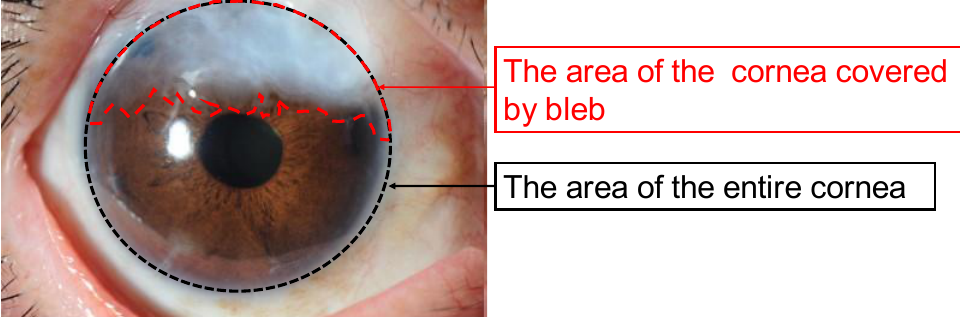
Figure 1. Clinical photographic image using slit lamp mounted camera and dimensions measured using NIH image J software. The ratio of cornea covered by bleb is the ratio of area of the cornea covered by bleb to entire cornea area. The red and black lines are the cornea covered by bleb area and entire cornea area, respectively.